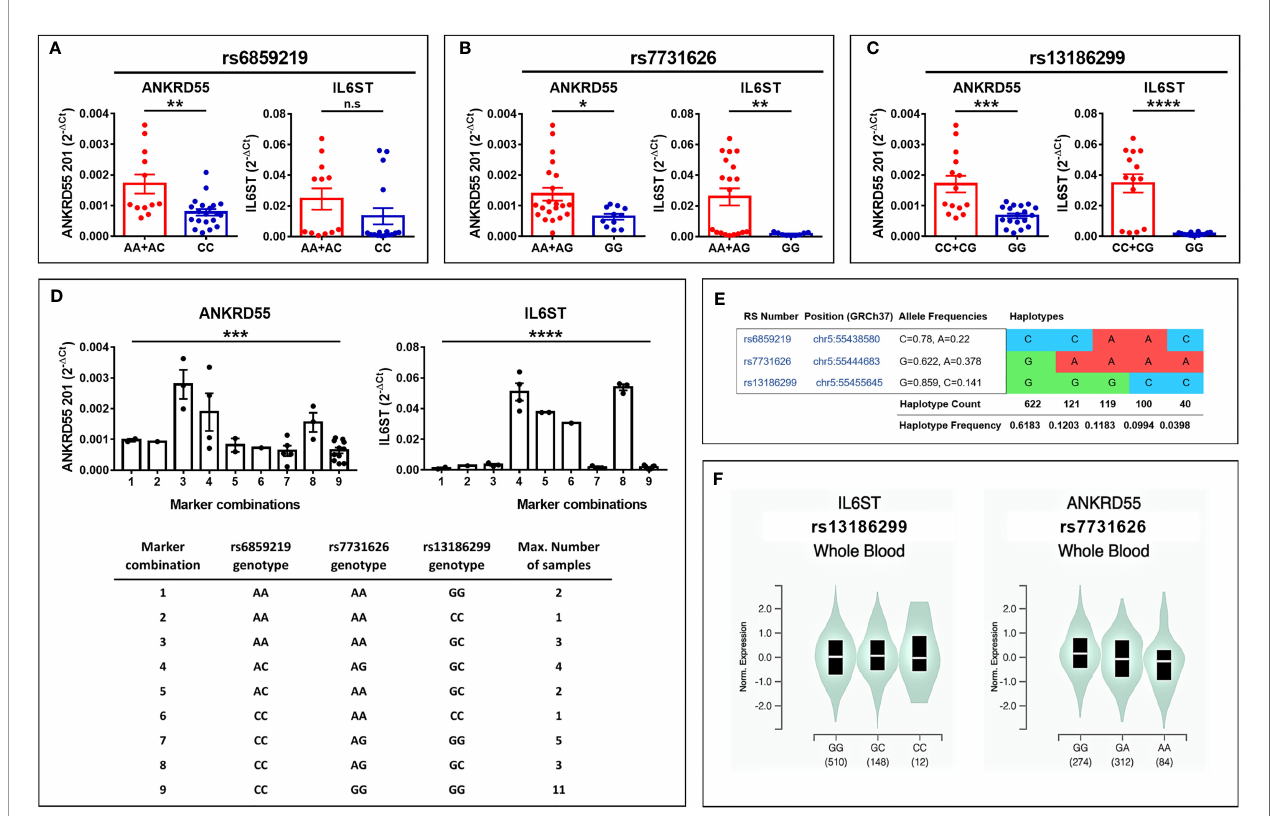
FIGURE 6 | (A – C) Modulation of ANKRD55 and IL6ST gene expression in immature moDC of healthy donors by cis genomic MS risk variants (mean ± SEM; n ≥ 28; Mann – Whitney test); (A) rs6859219, (B) rs7731626, and (C) the correlated ANKRD55 -intronic SNP rs13186299. (D) Assessment of ANKRD55 and IL6ST expression levels according to three-SNP marker combinations (mean ± SEM; n ≥ 28; one-way ANOVA test). (E) Haplotype distribution in the European population of the three SNPs. Image information was produced by means of ldlink.nci.nih.gov. (F) Genomic variants rs13186299 (left) and rs7731626 (right) are the most signi fi cant single- tissue eQTLs for IL6ST and ANKRD55 in whole blood, respectively, based on information collected from the GTEx portal (gtexportal.org/home/). The risk genotype of each of both SNPs is GG, and the protective allele is C for rs13186299 and A for rs7731626. * p ≤ 0.05, ** p ≤ 0.01, *** p ≤ 0.001, **** p ≤ 0.0001. n.s., not signi fi